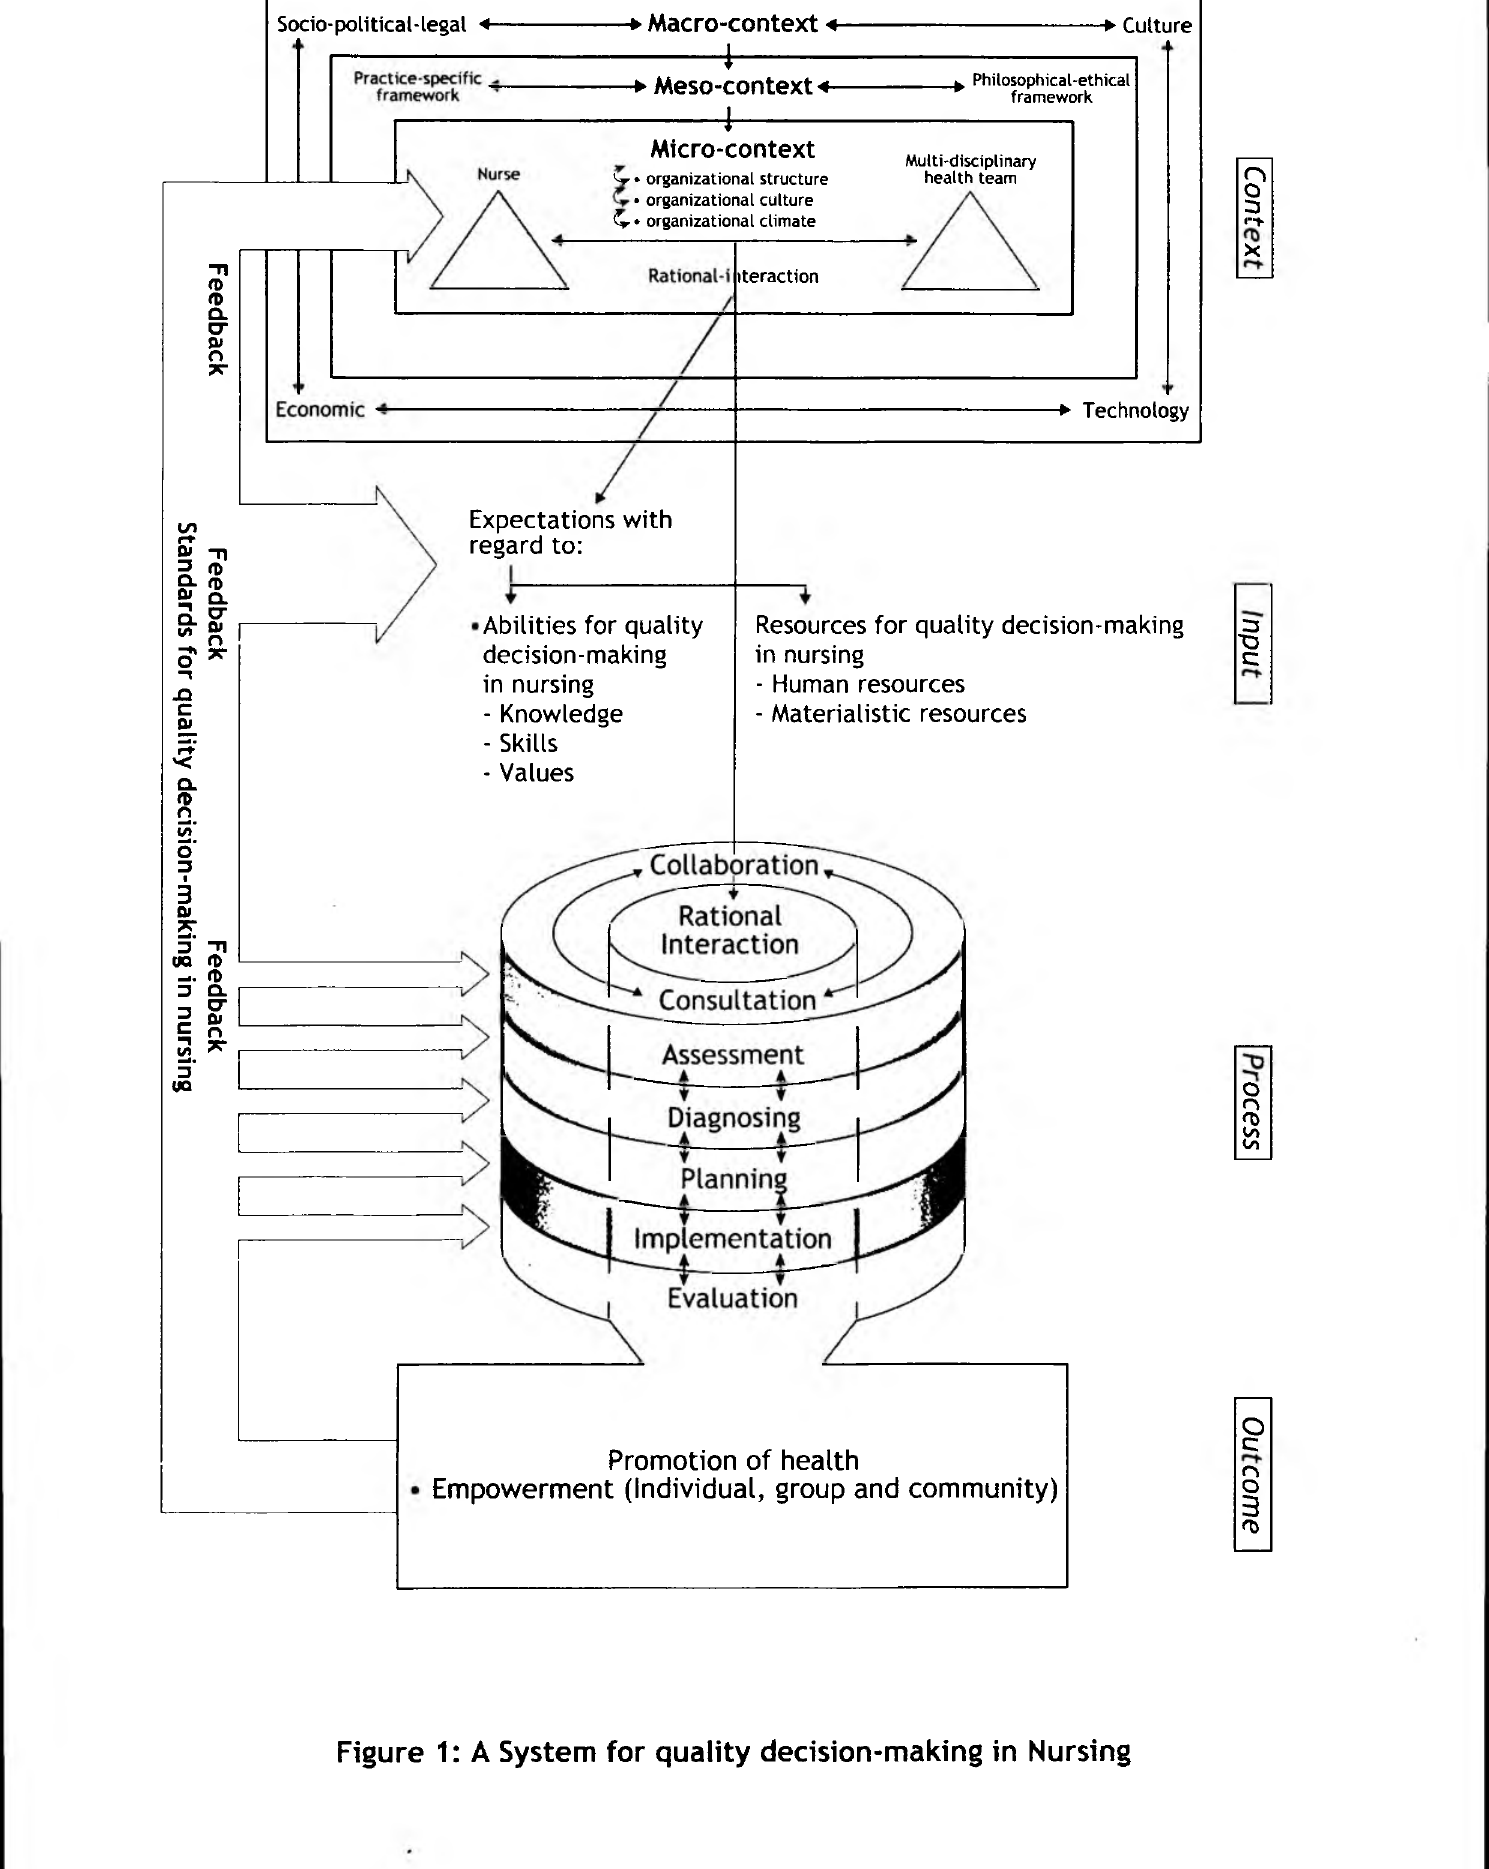
Figure 1: A System for quality decision-making in